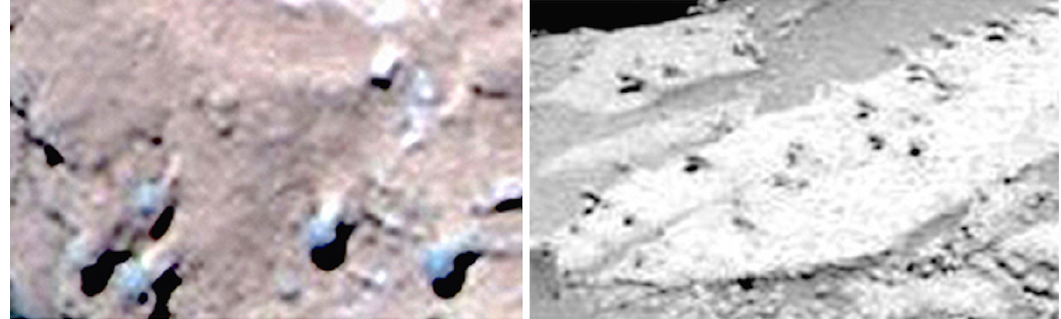
Figure 14. Mars. Sol 35 and Sol 85: Specimens resembling the mushroom-shaped lichen Dibaeis baeomyces and examples of colonies of lichen-shaped organisms. Photographed in Eagle Crater. (Reproduced with permission from Joseph et al. 2020b).